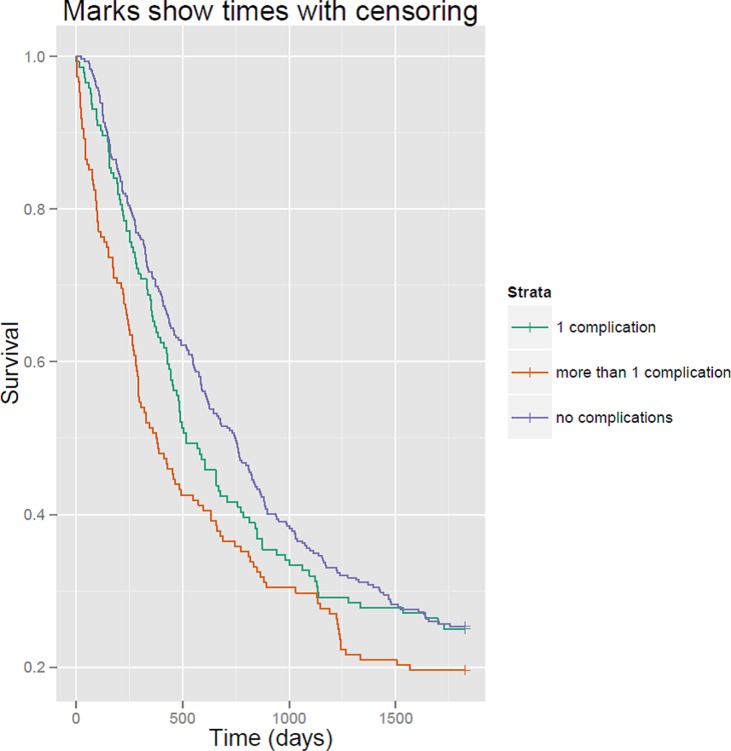
Kaplan Meier curve showing survival time in days by exposure group.